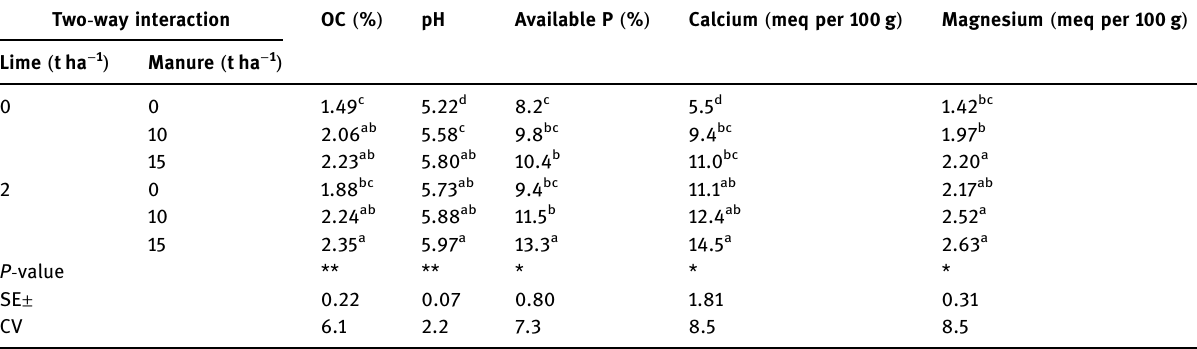
Table 3: Interaction e ff ects of cattle manure and lime on OC, available P, pH, calcium, and magnesium after tef harvest in northwest Ethiopian highlands